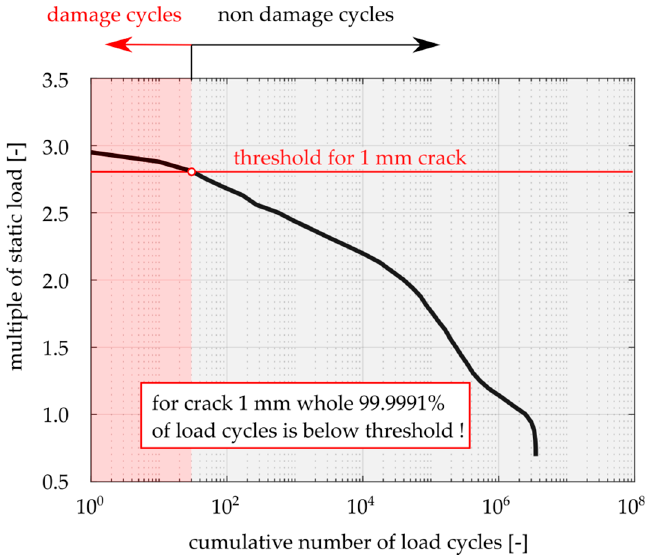
Figure 20. Typical load spectrum corresponding to 10,000 km of train operation.